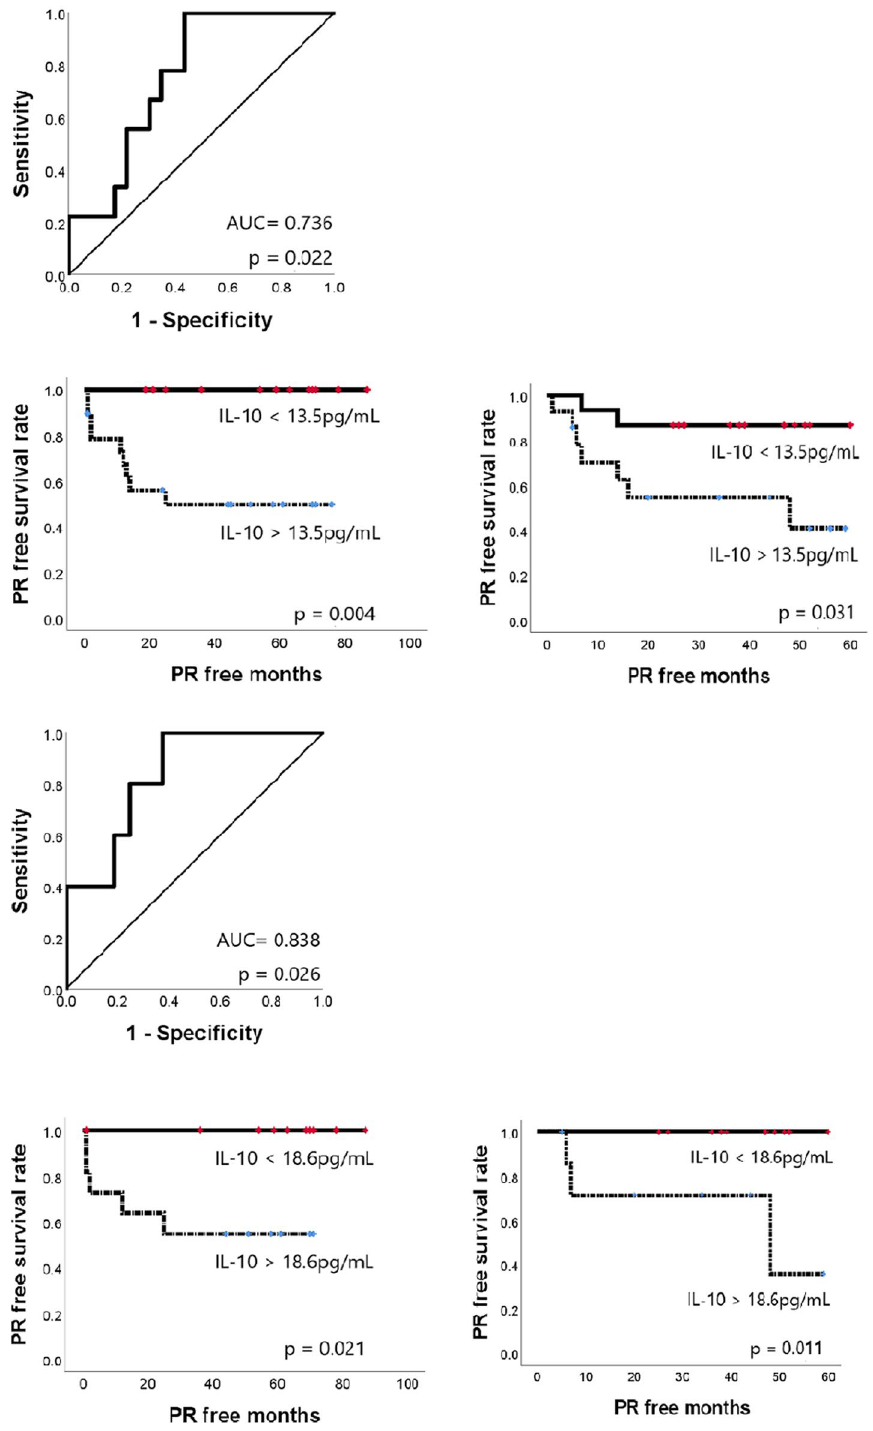
Figure 5. Classification performance of the IL10 cut-off model. ( a ) ROC curve from cohort I (n = 32) showed an AUC of 0.736 (p = 0.022). The relevant cut-off value was 13.5 pg/mL. ( b ) The difference in PR in cohort I was significant (p = 0.004; no PR of 13 for ≤ 13.5 pg/mL and 9 PR of 19 for > 13.5 pg/mL in cohort I). ( c ) The difference in PR in cohort II (n = 29) was also significant (p = 0.031; two PRs of 15 for ≤ 13.5 pg/mL and 7 PRs of 14 for > 13.5 pg/mL in cohort II). ( d ) The ROC curve from cohort I without SR (n = 21) showed an AUC of 0.838 (p = 0.026). The relevant cut-off value was 18.6 pg/mL. ( e ) The difference in PR in cohort I without SR was significant (p = 0.021; no PR of 10 for ≤ 18.6 pg/mL and 5 PR of 11 for > 18.6 pg/mL in cohort I). ( f ) The difference in PR in cohort II (n = 21) without SR was also significant (p = 0.011; no PR of 13 for ≤ 18.6 pg/mL and 3 PR of 8 for > 18.6 pg/mL in cohort II). ROC receiver operating characteristic, AUC area under the curve, PR peritoneal recurrence, SR systemic